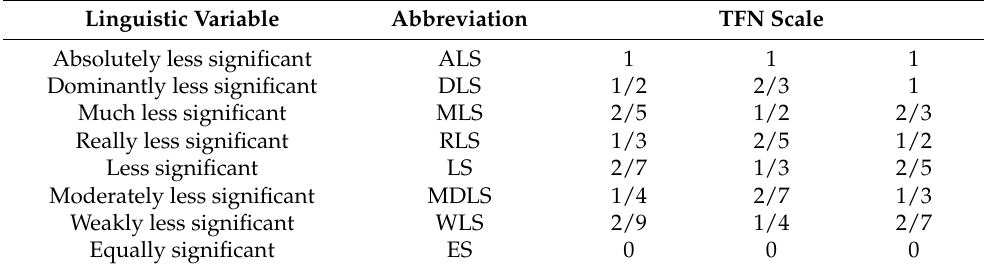
Table 1. Linguistics and the TFN